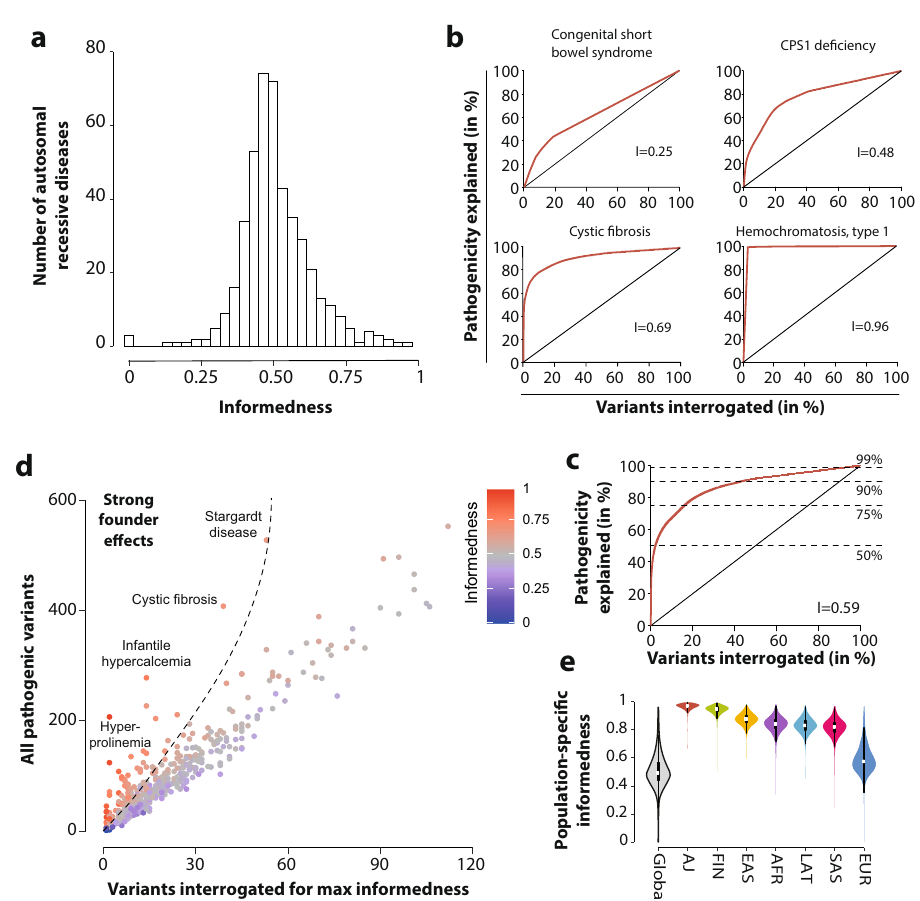
Fig. 3 Genetic complexity and founder effects differ drastically across autosomal recessive diseases and populations. a Histogram showing the distribution of gene-speci fi c informedness for 450 AR diseases. b Examples of receiver operating characteristic (ROC) curves of autosomal recessive diseases with high (type I hemochromatosis), medium (cystic fi brosis and CPS1 de fi ciency), and low informedness (congenital short bowel syndrome). c Aggregated ROC curve for all 450 analyzed diseases. Informedness values for all 450 analyzed diseases and the number of variants to be interrogated to capture 50, 75, 90, and 99% of disease cases are provided in Supplementary Data 6. d Color- coded scatter plot showing the association between the number of pathogenic variants per gene (ordinate) and the number of variants that need to be interrogated for maximal effectiveness of genetic testing (abscissa). The informedness for each disease is color-coded from blue (low informedness) to red (high informedness). Note that for certain diseases, such as hyperprolinemia, infantile hypercalcemia, and cystic fi brosis variants are strongly overrepresented, suggesting strong founder effects, whereas other diseases, such as persistent Mullerian duct syndrome and Brody myopathy show no indication of founder effects. e Violin plot showing population differences in informedness distributions. White dot indicates the median value of the distribution, while the black boxes indicate the spans between the fi rst and third and population speci fi city is available for most Mendelian disorders. Combined, this lack of data hampers studies of AR disease genetics and impedes the implementation of genetic screening programs for the majority of AR diseases. By integrating population-scale sequencing data of >140,000 individuals with a curated disease genetics knowledgebase and stringent computa- tional analyses, we provide a comprehensive map of the human genetic AR disease landscape that considers both established pathogenic variants, as well as rare and novel variants with